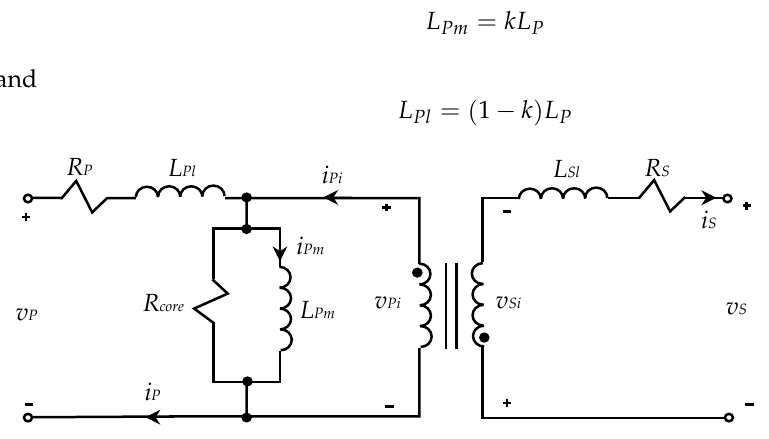
Figure 3. The equivalent circuit of the transformer.